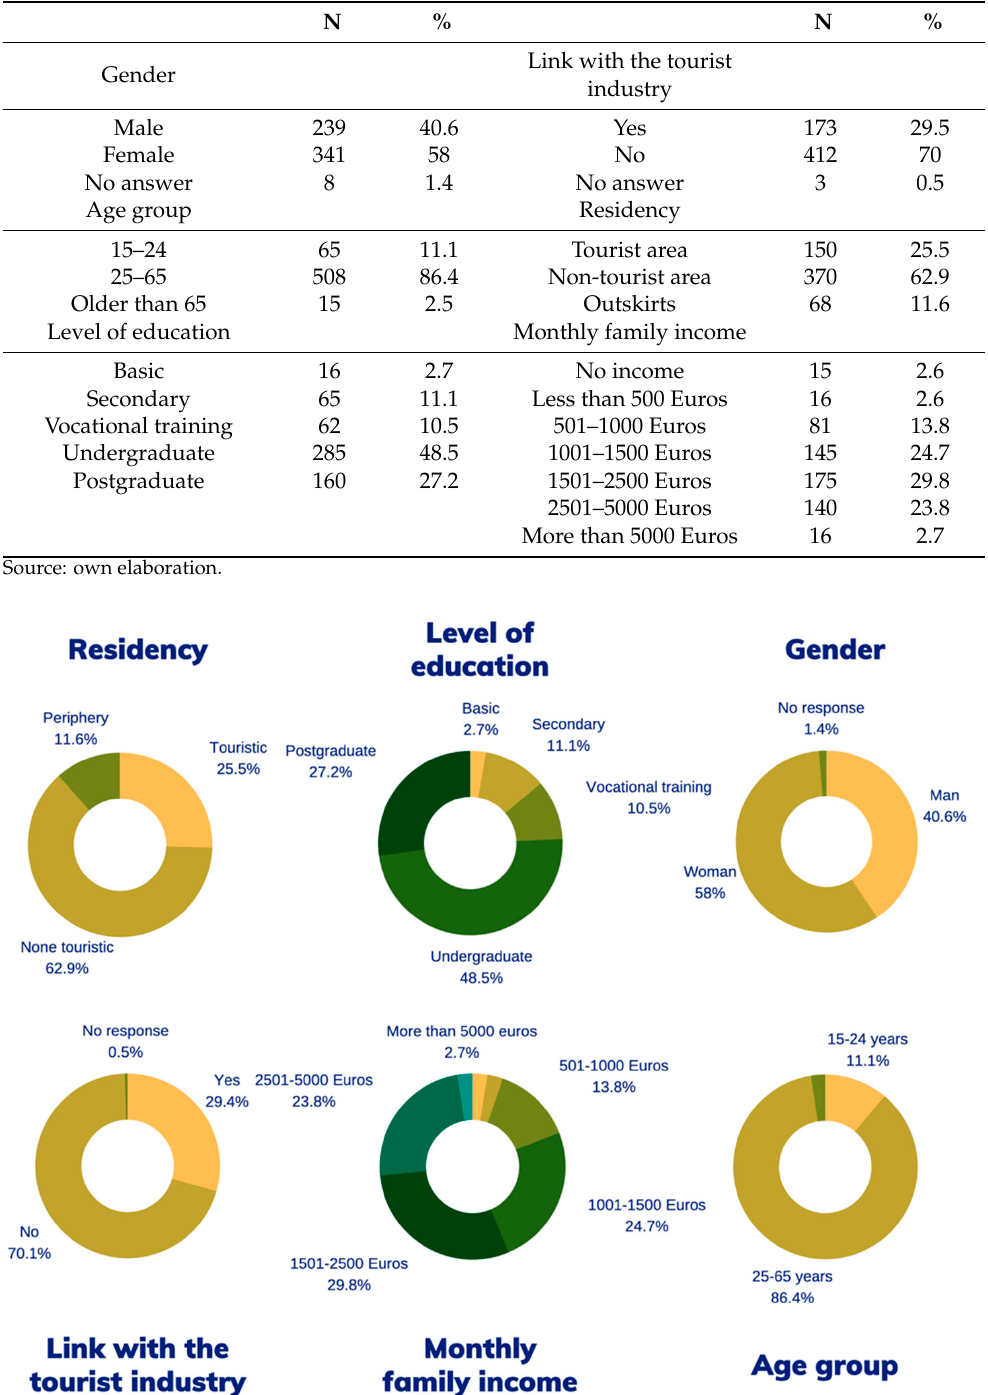
Table 1. Profile of respondents.